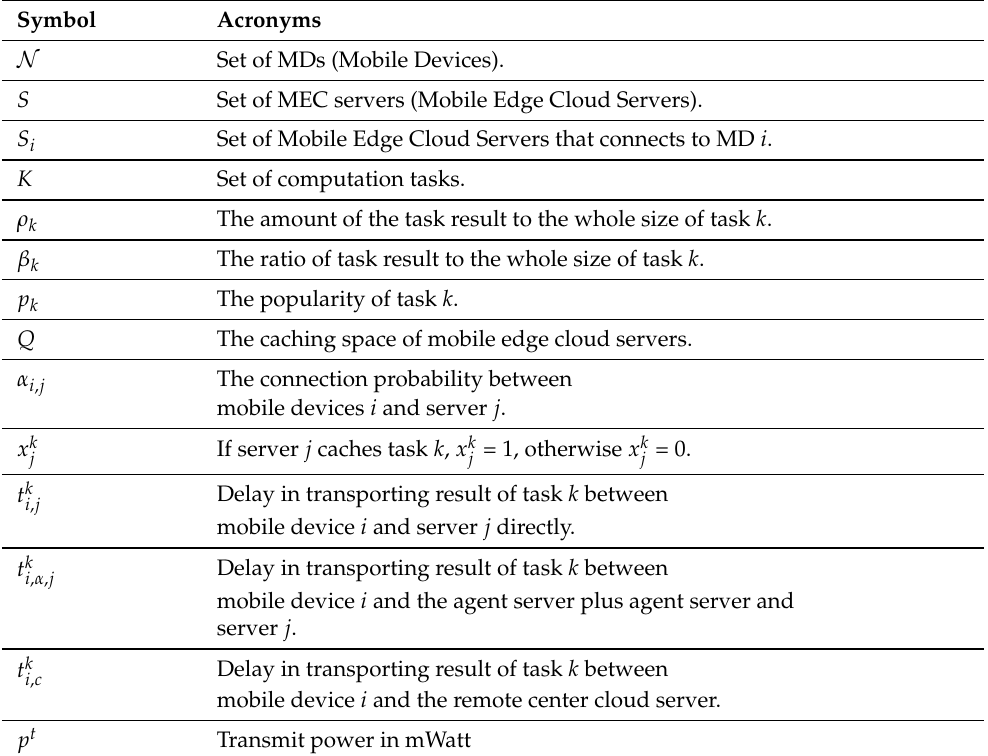
Table 1. List of Symbols and